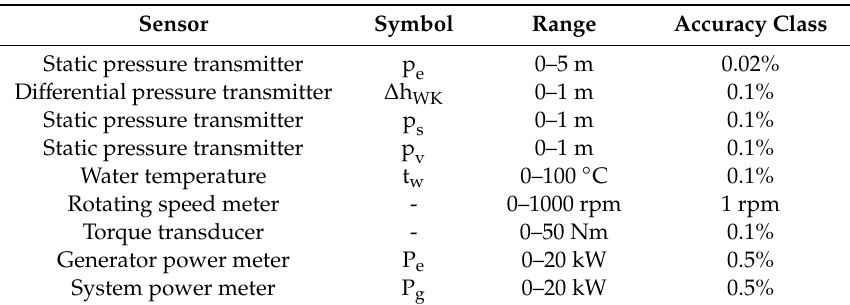
Table 3. Main characteristics of the